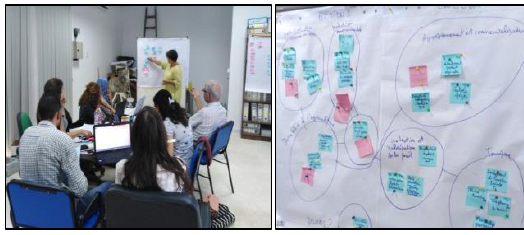
Figure 4. Analysis of the territory game outputs. Photo 1. Analysis of the territory game outputs.